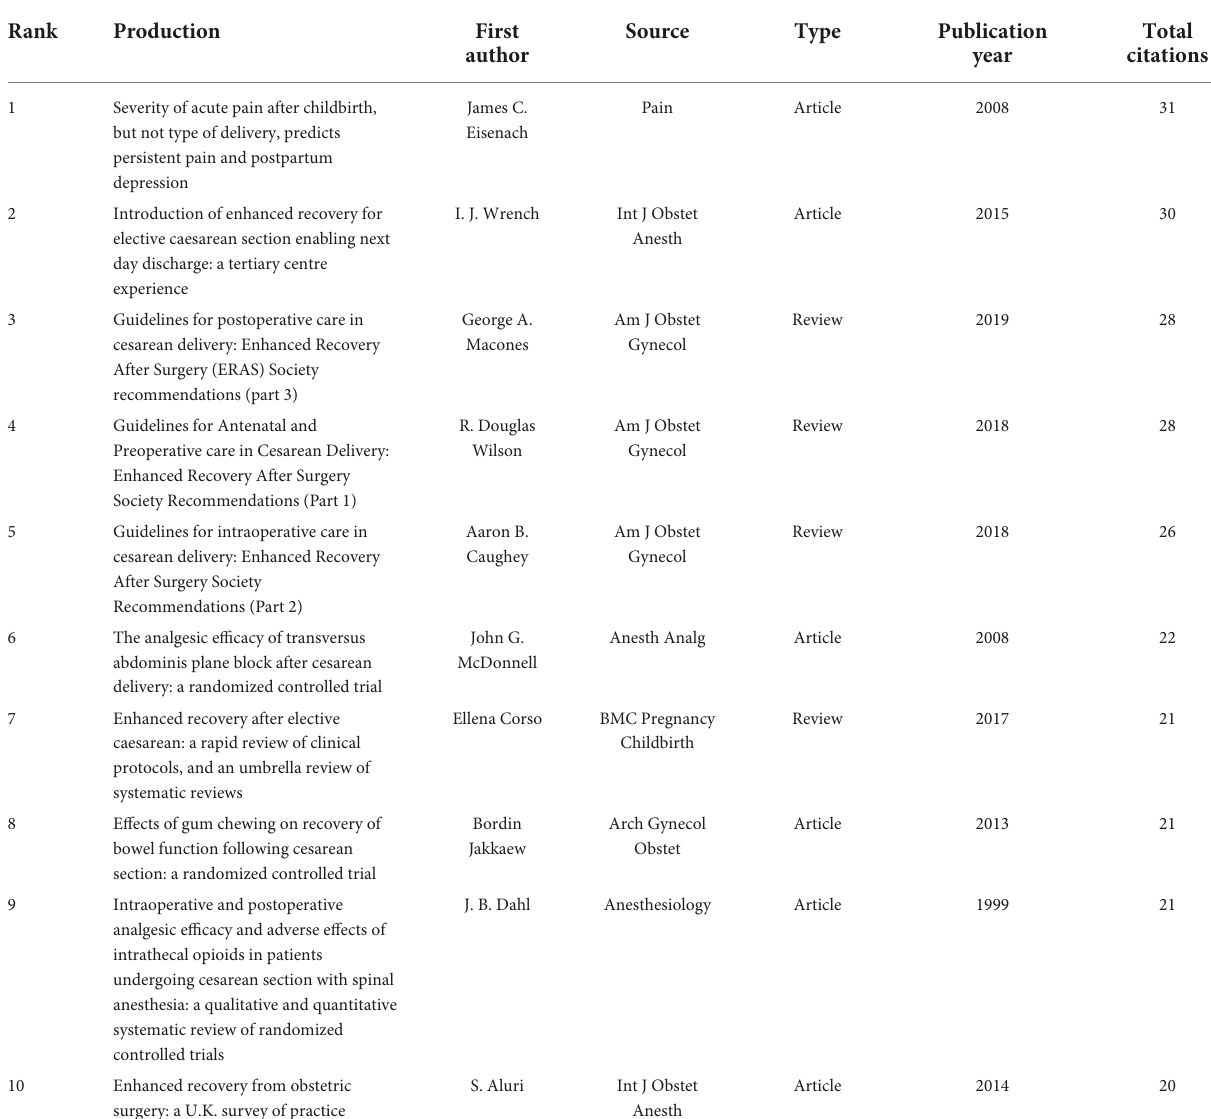
TABLE 5 Top 10 Co-citation of cited